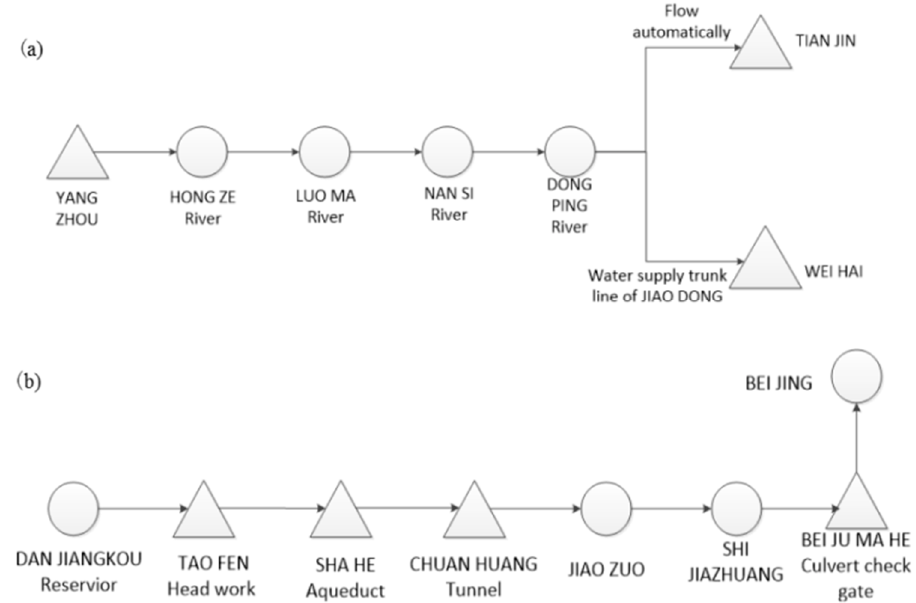
Figure 5. Location and different dispatching lines of the South-to-North Water Diversion (SNWD): ( a ) eastern module; ( b ) middle module.